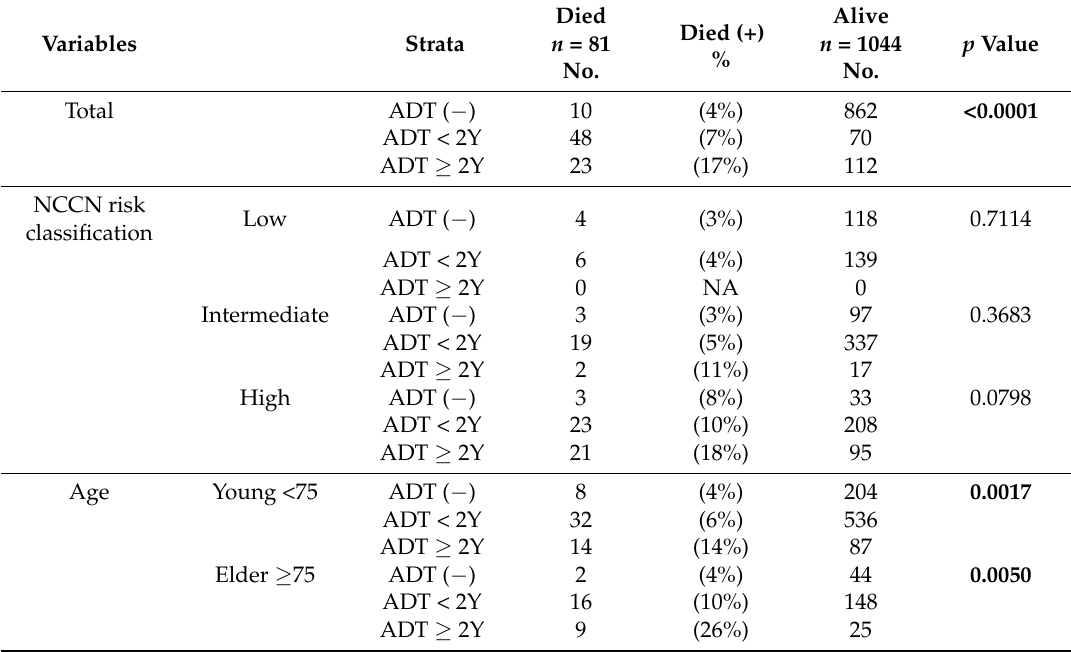
Table 2. Characteristics and treatment factors of patients with overall survival (mortality) according to duration of ADT.